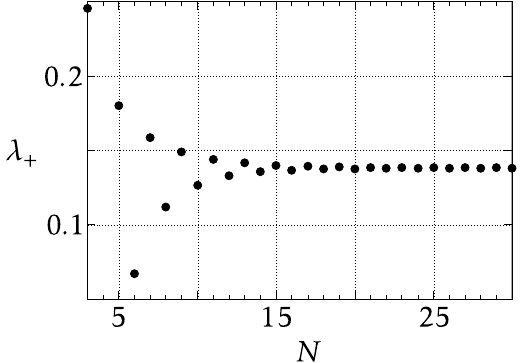
Figure 5. Phase transition point λ + of the entangled graph for different system